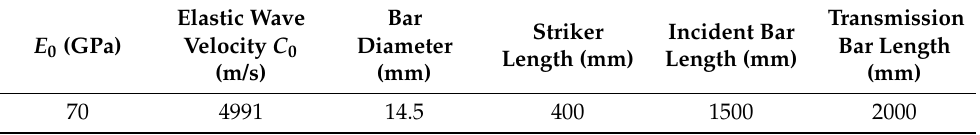
Table 2. Parameters of the split Hopkinson pressure bar